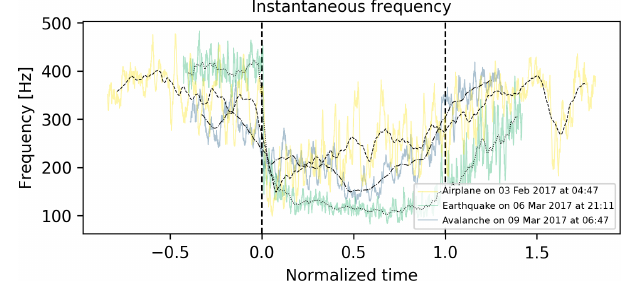
Figure 10. Instantaneous frequency with normalized time (normal- ized with event duration) for signals generated by an airplane (yel- low), an earthquake (green) and an avalanche (blue). The black lines are the moving mean. The black vertical dashed lines at zero and one indicate the start and the end of the events. Figure 11. Number of events during the season. Yellow bars in- dicate the events detected at both arrays, turquoise bars show the events only recorded at the Dischma array and blue bars show the events automatically detected at the Wannengrat array. Between 5 and 20 January no data were recorded at the Wannengrat